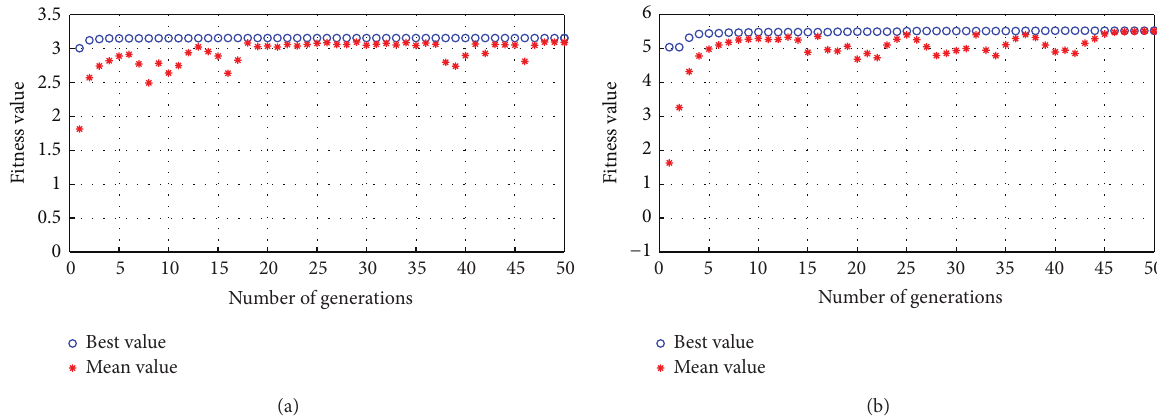
Figure 3: Evolution of the mean and best values of fitness function for finding actuator-sensor locations when the first three modes are controlled, while the next two modes are the residual modes: (a) one actuator-sensor and (b) a pair of